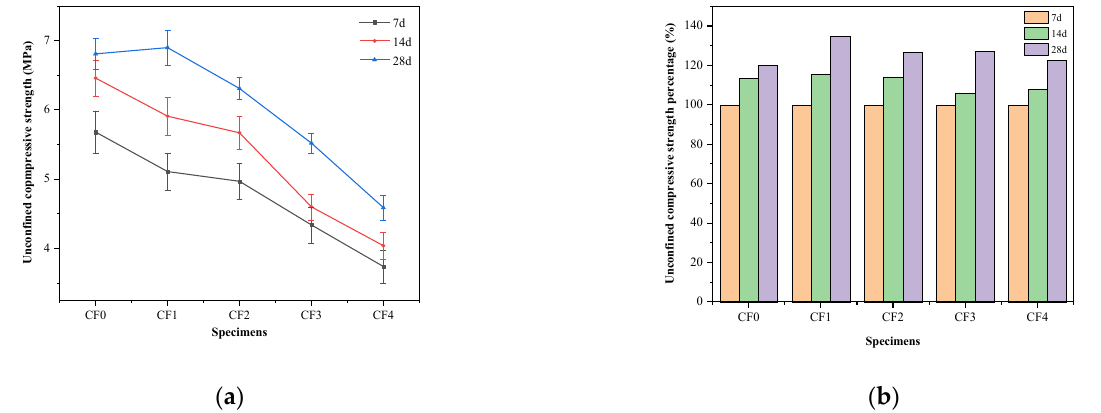
Figure 2. ( a ) UCS of the CSM with 100% RMA under different fly ash replacement rates and ( b ) the ratio of UCS at different ages to the 7 d strength.